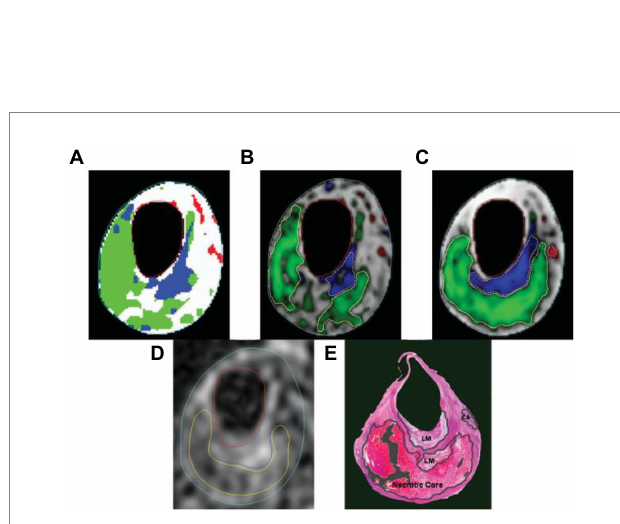
FIGURE 6 The following segmentation results are displayed on a T2-weighted image. (A) Automatic labeling result by Gaussian classifier. (B) Probability map and region contours based only on intensity, with a necrotic core in green, calcification in a red, loose matrix in blue, and fibrous tissue in gray. (C) Corresponding results with morphologic information. (D) Manual segmentation result. (E) Corresponding histology specimen used to direct contour placement in (D) dark